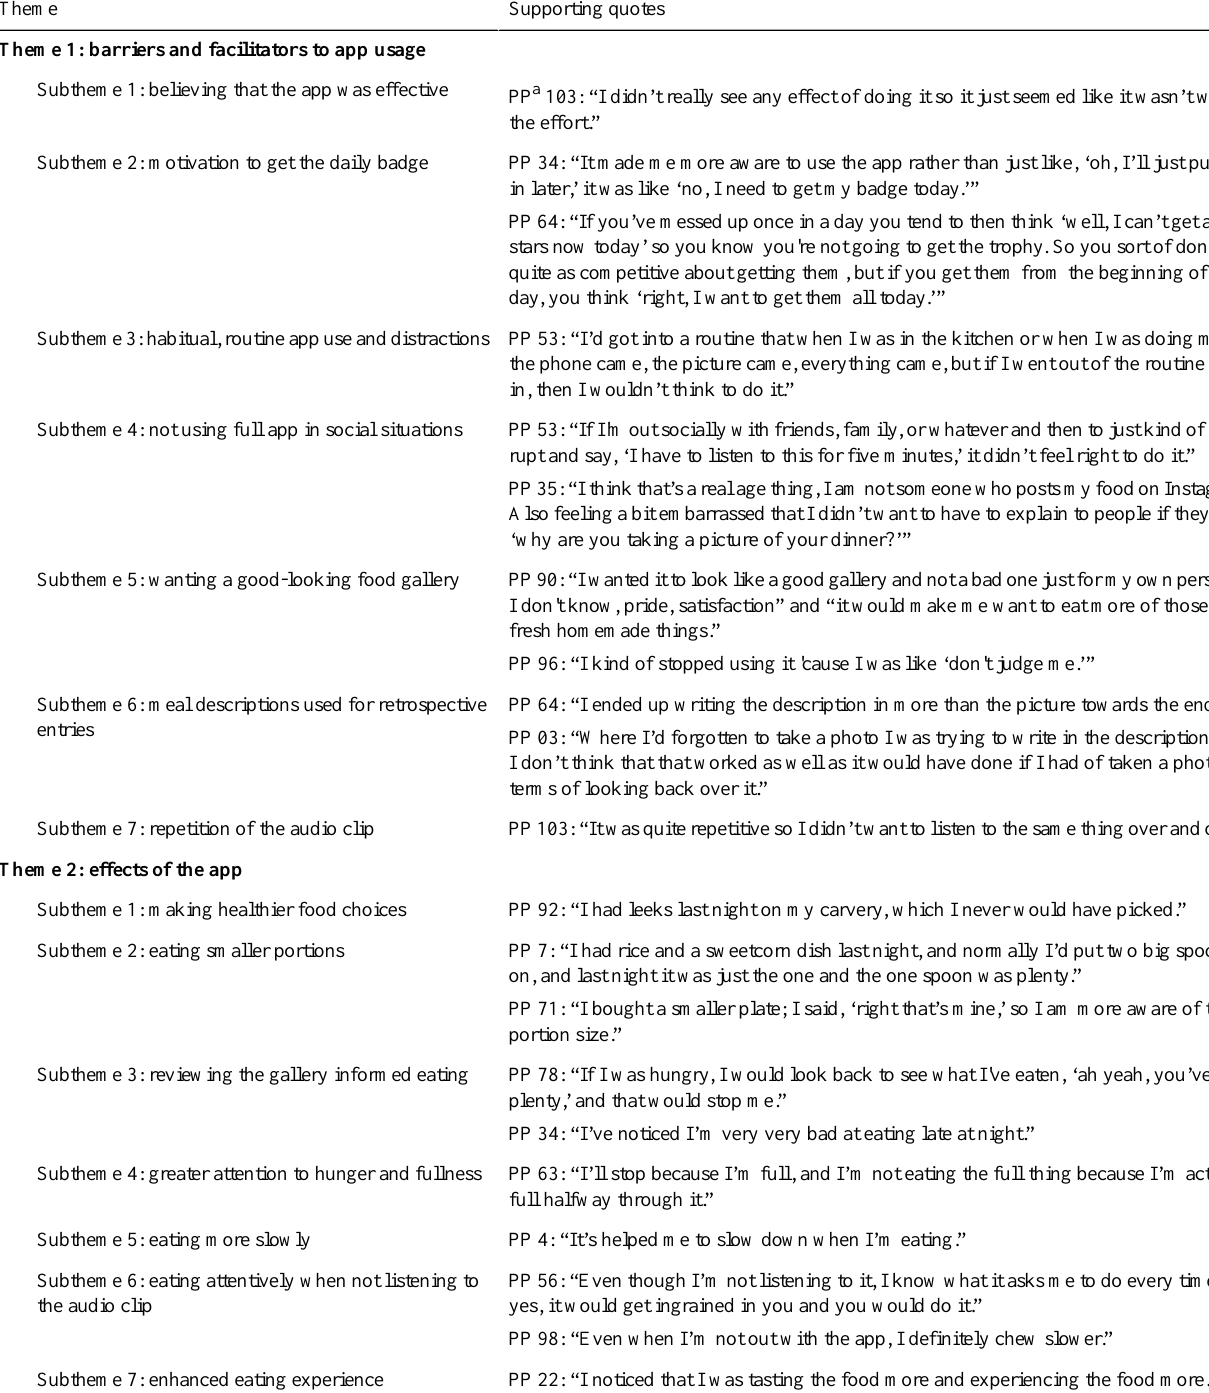
Supporting quotesTheme